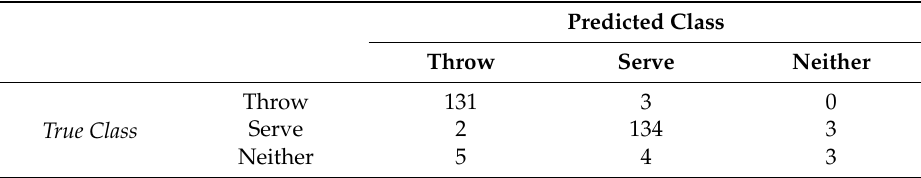
Table 2. Confusion matrix for the sport activity classifier over training and testing